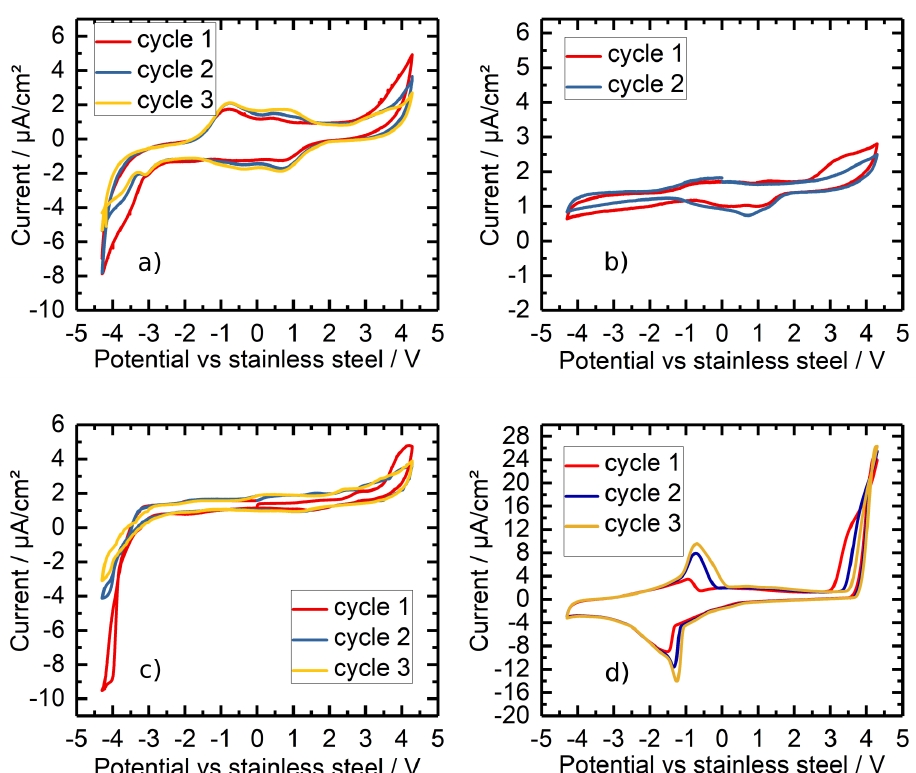
Figure 7. Electrochemical stability window of ( a ) LP40, ( b ) 1 M LiPF 6 dissolved in TBAC:EC:EMC: DEC (60:15:5:20 wt), ( c ) 1 M LiTFSI in TBAC:EC:EMC:DEC (60:15:5:20 wt) (all with stainless steel